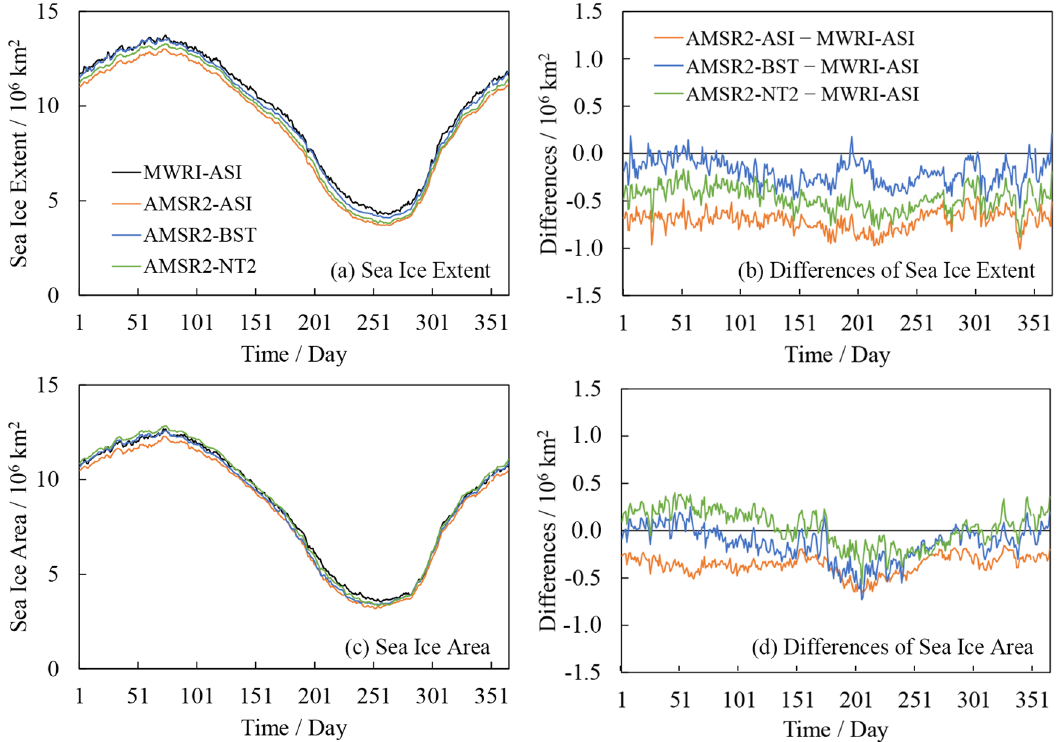
Figure 5. Daily (a) sea ice extent, (c) sea ice area of MWRI-ASI (black), AMSR2-ASI (orange), AMSR2-BST (blue) and AMSR2- NT2 (green). Differences of (b) sea ice extent, (d) sea ice area between AMSR2-ASI (orange), AMSR2-BST (blue), AMSR2-NT2 (green) and MWRI-ASI in the full year of 2018.